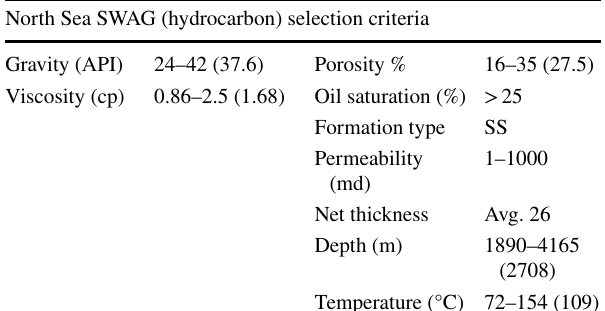
Table 8 North Sea SWAG screening